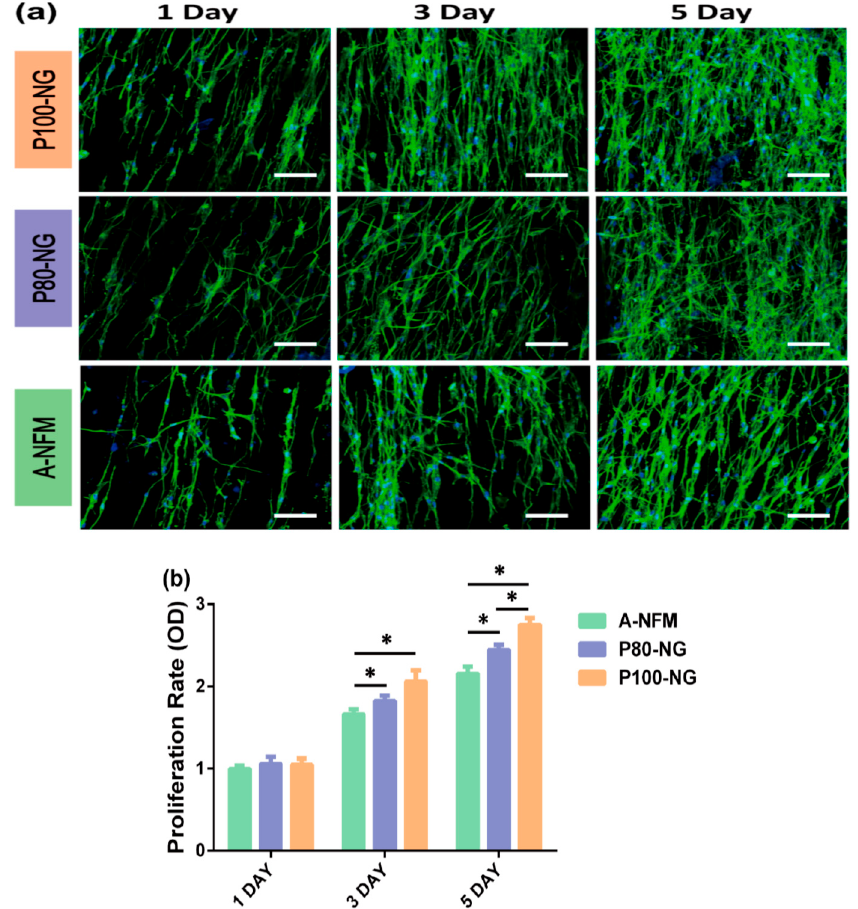
Figure 23. ( a ) Fluorescence micrographs of MC3T3 cells cultured on fibrous A-NFM, P80-NG, and P100-NG mats for 1, 3, and 5 days. The scale bar is 100 µm. ( b ) Proliferation of MC3T3 cells on P80-